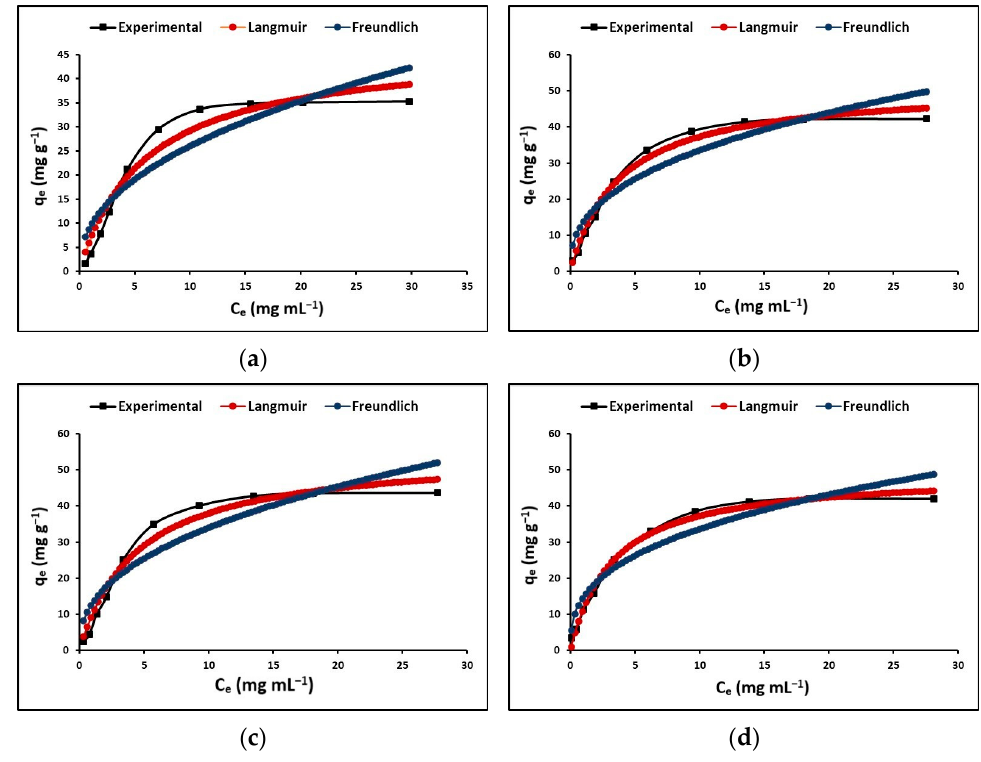
Figure 7. Adsorption isotherms of ( a ) TO, ( b ) La/TO, ( c ) Ce/TO, and ( d ) Eu/TO.